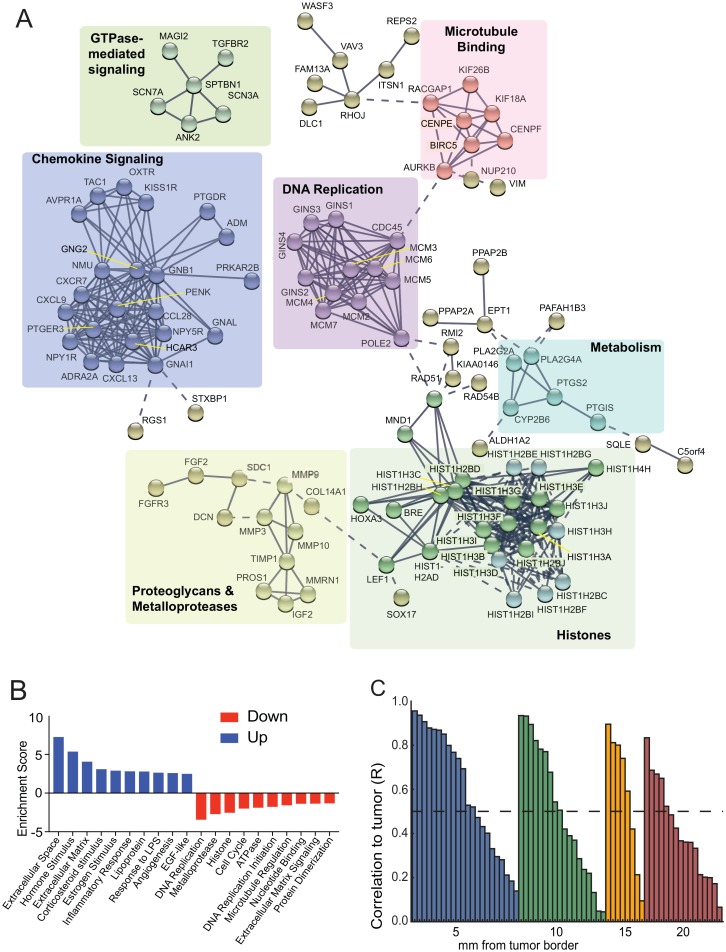
Molecular and biochemical pathway analysis of tumor-like gene expression signature.(A) STRING network analysis using a highest (0.9) confidence minimum required interaction score, showing no more than 10 interactors and removing all disconnected nodes in the network. Network clustering was done using k-means clustering. Pathway labels indicate KEGG pathway or GO Terms significantly enriched (Benjamini < 0.05) in that set of genes. (B) DAVID pathway analysis of tumor-like genes. Top ten most significant pathways in gene expression profiling that are up-regulated or down-regulated compared to tumor. (C) Pearson correlation of each patient’s tumor and stromal distance. Stromal distance R values were aggregated based on distance. Pearson correlation pertains to each patient’s tumor with all stromal tissues represented from that patient.